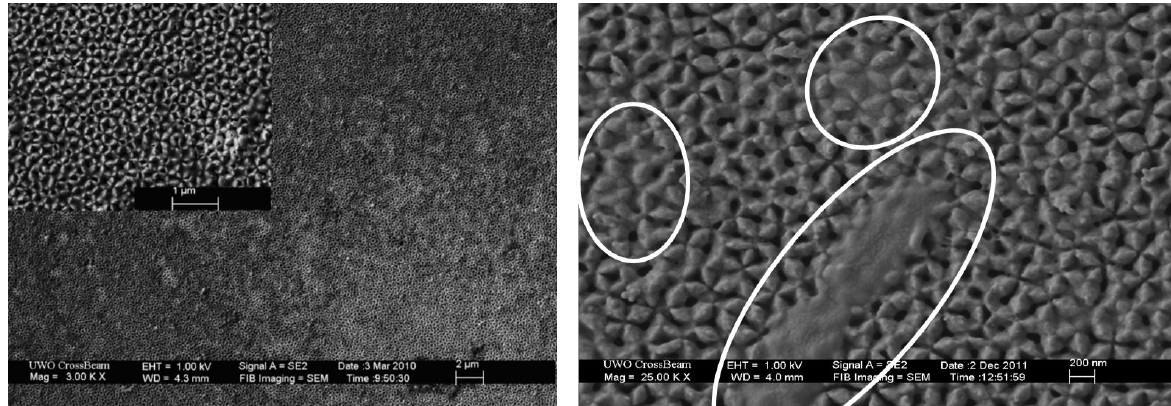
Figure 3. SEM photographs of the self-assembled ultra-thin bR film on porous PAA substrate with increasing magnification. The enlarged area is shown in the upper left corner of the low magnification left photograph. Note that areas of significant PM coverage are encircled in white for the highly magnified image in the right